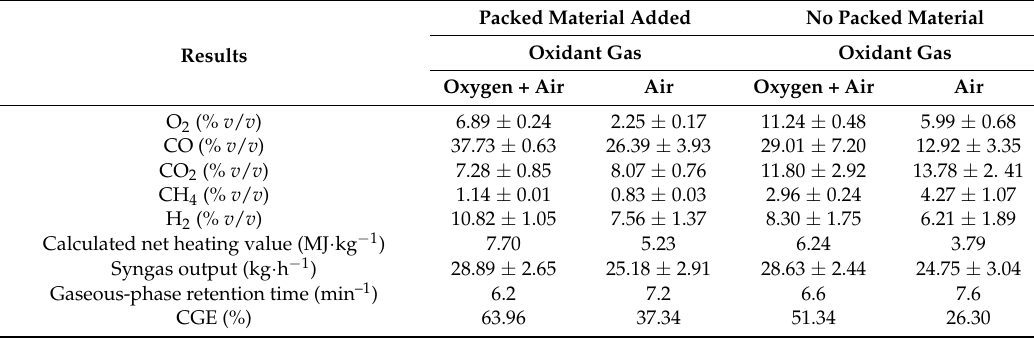
Table 8. Average dry-basis syngas composition obtained from experimental assays.